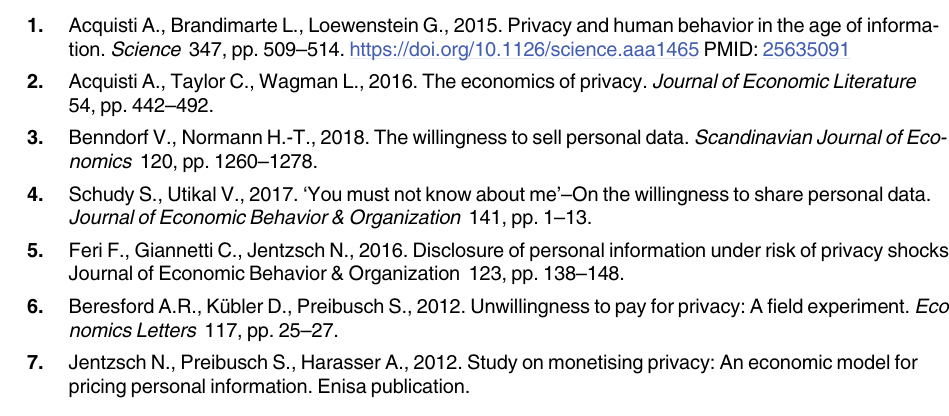
S4 Fig. Information sheets ( reduced treatments). S5 Fig. Money sheets ( main treatments). S6 Fig. Money sheets ( reduced